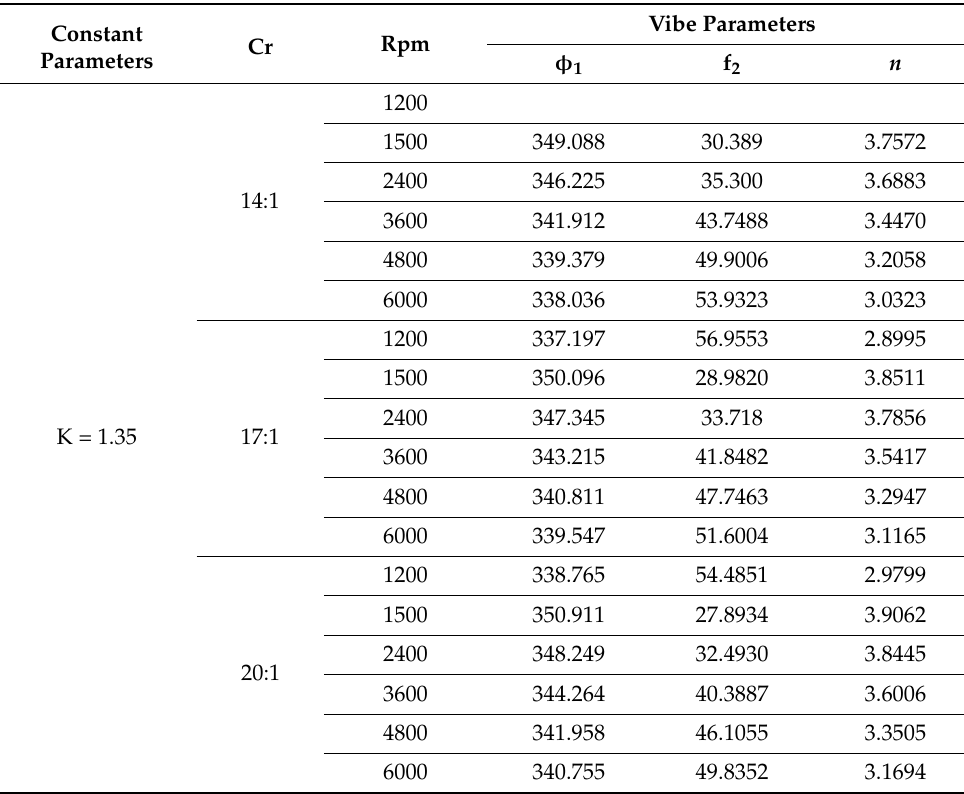
Table 1. Parameters for creating a Vibe function. Constant